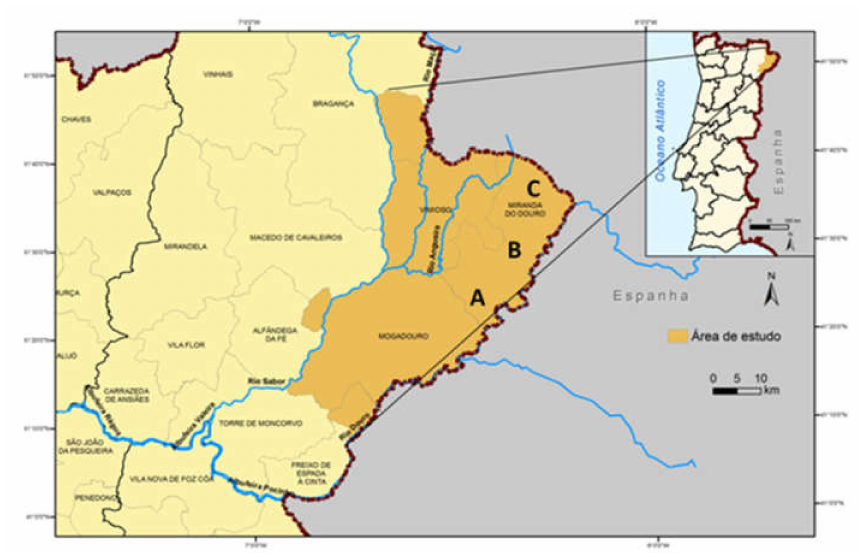
Figure 1. Location of the study area in the northeast of Portugal and of the rehabilitation centers of the Association for the Study and Protection of Donkeys (AEPGA) A—Atenor; B—Duas Igrejas; C—Pena Branca (adapted from Meirinhos, 201